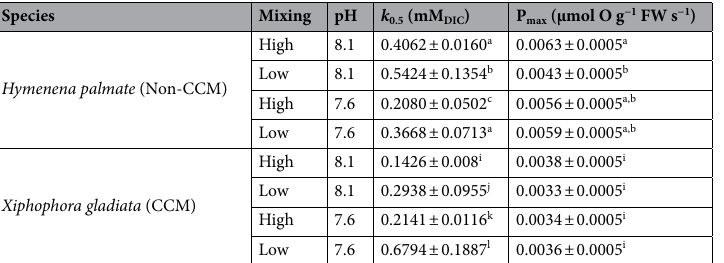
Species Mixing pH k 0.5 (mM DIC ) P max (μmol O g −1 FW s −1 ) High Hymenena palmate (Non-CCM)